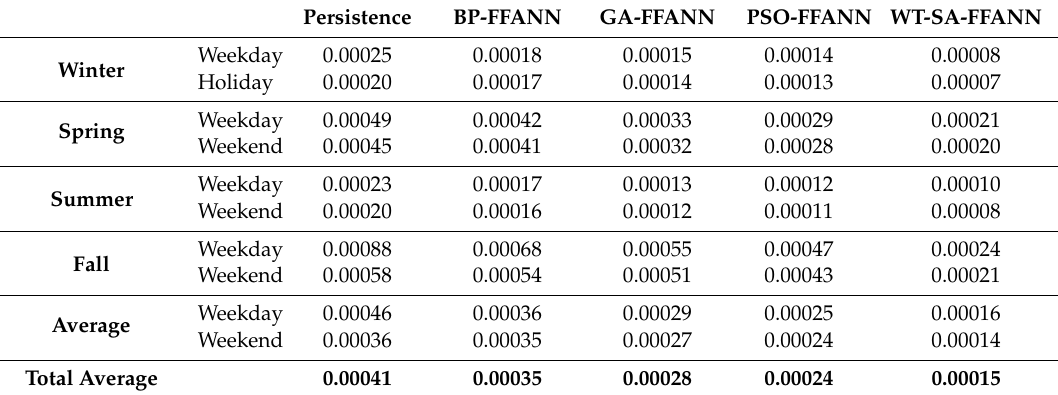
Table 6. Comparative forecast error-variance.